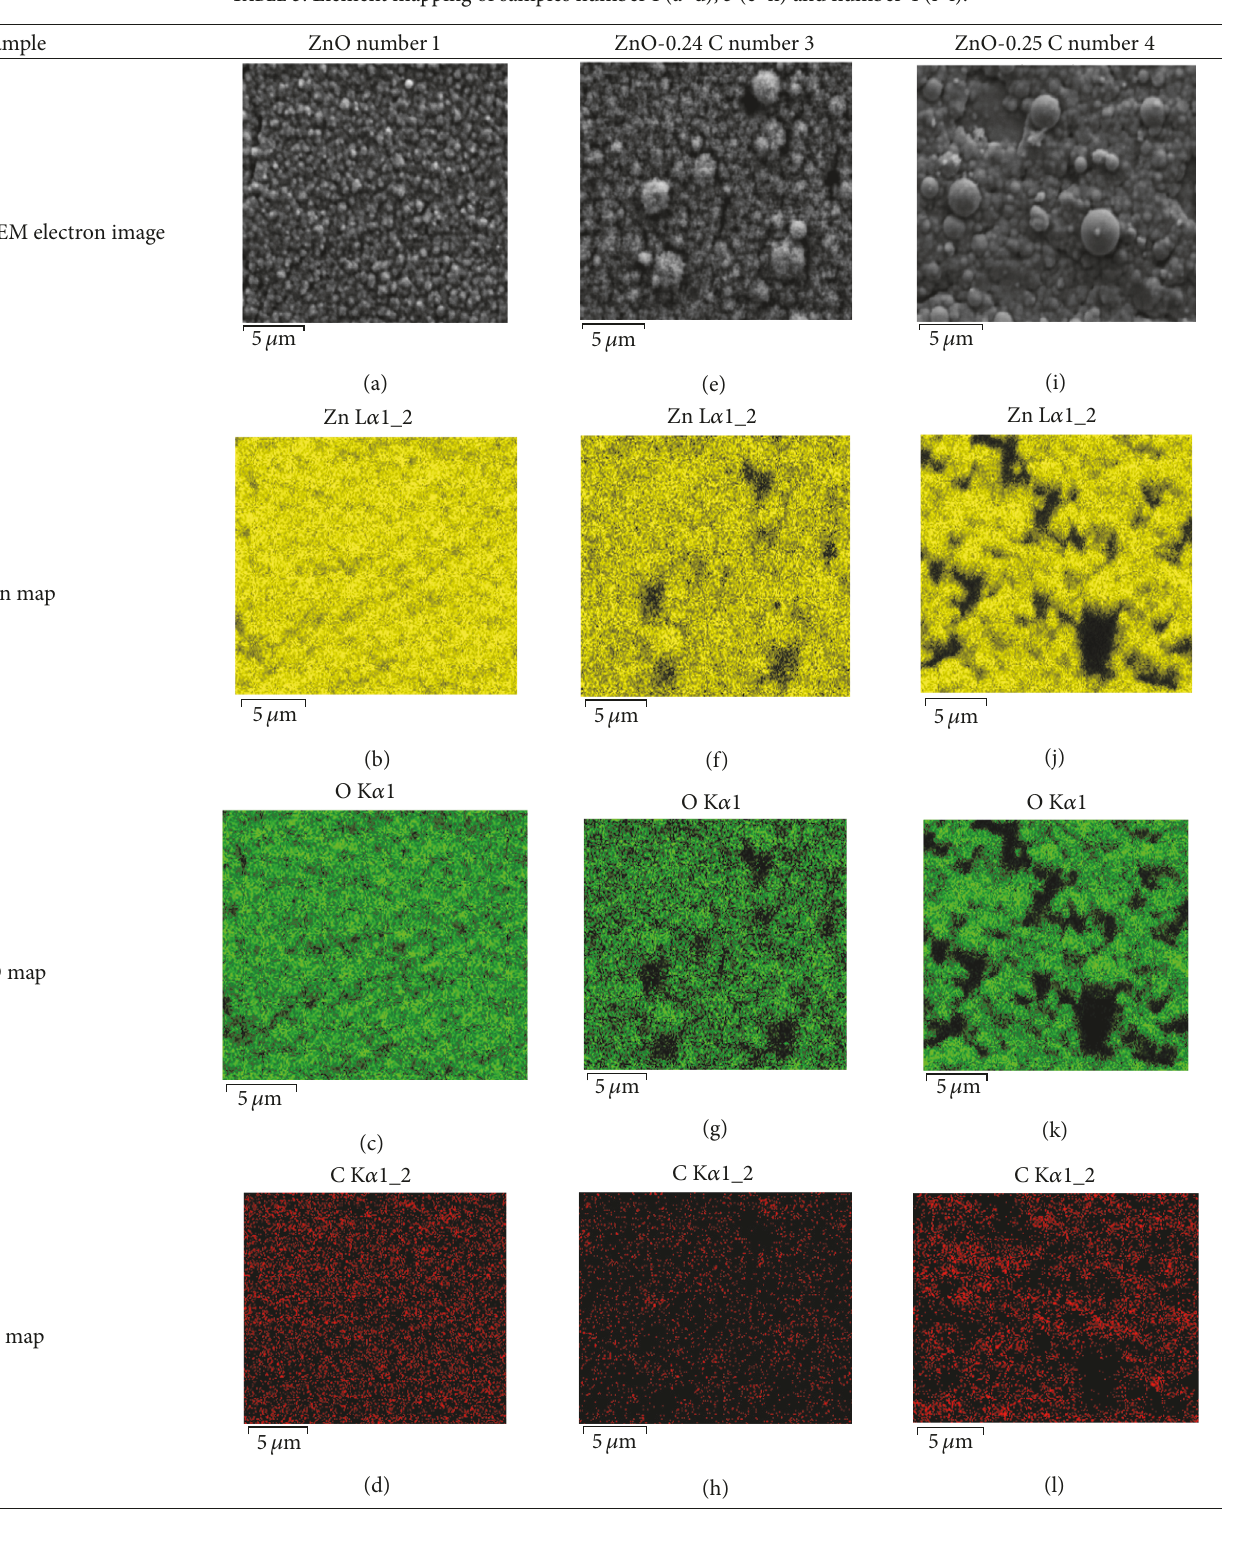
Table 3: Element mapping of samples number 1 (a–d), 3 (e–h) and number 4